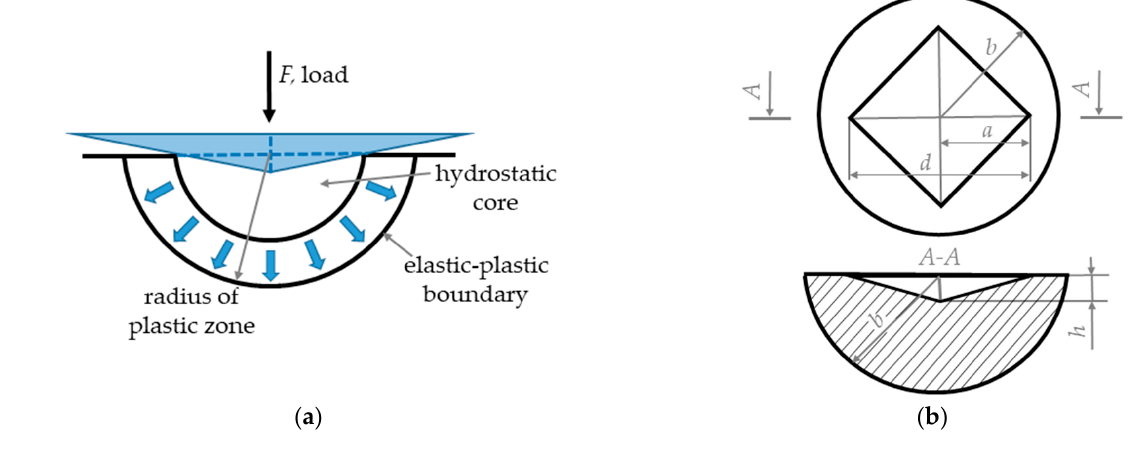
Figure 2. The plastic zone under the indenter ( a ) and its sections ( b ).